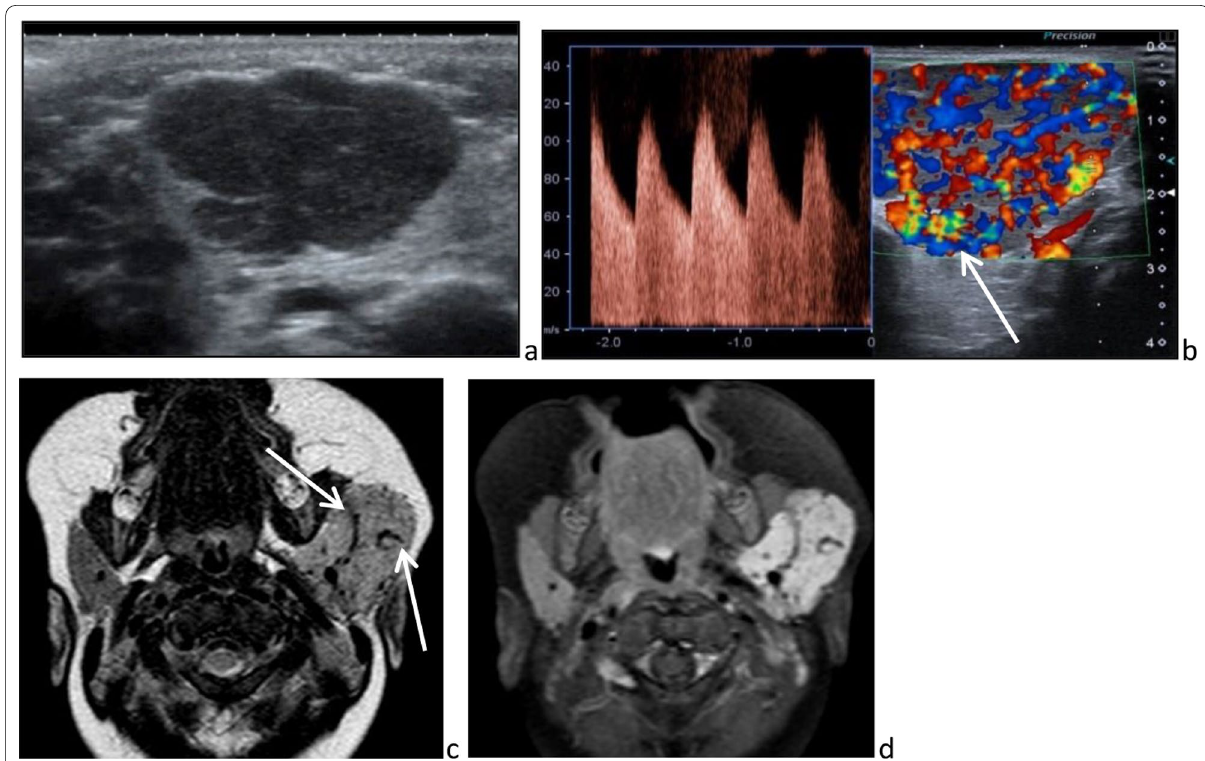
Fig. 13 Infantile hemangioma. Lobulated, hypoechoic and hypervascular mass ( a ) containing high velocity and low resistance arteries ( b ), on ultrasonography. Diffuse enlargement of the left gland by strongly enhanced mass containing tortuous vessels responsible for flow void images [white arrows], on axial T 2 ‑weighted image ( c ) and T 1 ‑weighted image, after intravenous injection of gadolinium chelate ( d